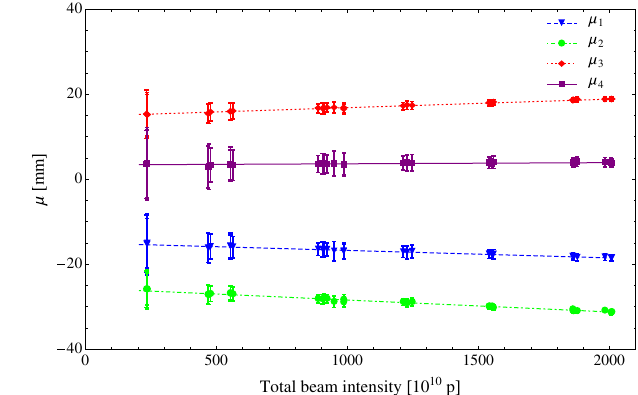
FIG. 9. Beamlets’ position (cid:5) i , from the fit using Eq. (6) of the data shown in Fig. 7, vs total beam intensity. The error bars represent the error associated with the fitting procedure. The larger errors for lower total beam intensities reflect the difficulty of representing the close-by peaks with five Gaussian distribu- tion functions, and also the effect of the constant gain used for the wire scanner throughout the whole measurement campaign.